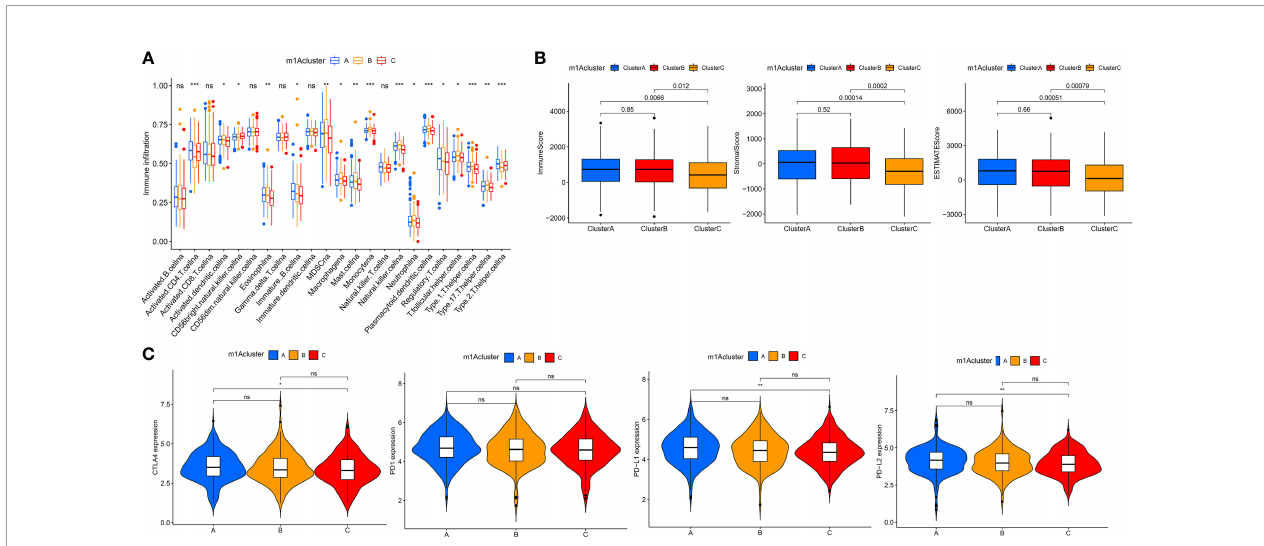
FIGURE 3 | TME cell in fi ltration characteristics and immune checkpoints in distinct m1A modi fi cation patterns. (A) The abundance of each TME in fi ltrating cell in three m1A modi fi cation patterns. (B) The box plot indicated the correlation between different m1A modi fi cation patterns and immune scores, stromal scores and estimate score. (C) The expression of CTLA-4, PD1, PD-L1 and PD-L2 among distinct m1A modi fi cation patterns. *P < 0.05; **P < 0.01; ***P < 0.001. ns, not signi fi